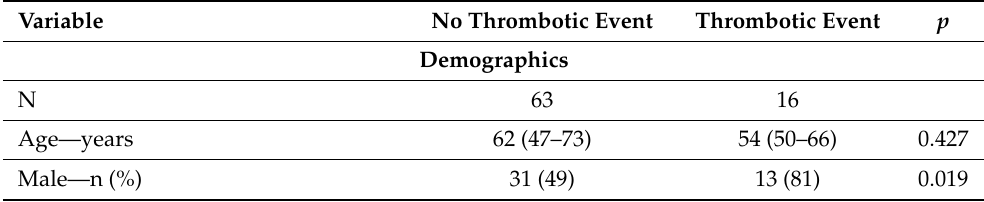
Table 1. Baseline characteristics of the studied